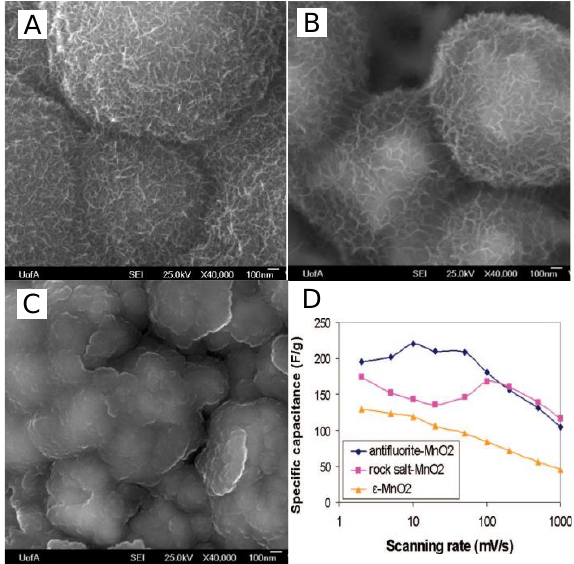
Figure 3. Morphology and crystal structure of manganese oxide prepared from 0.3 M MnSO 4 solution: SE image of ( A ) without any complexing agents, ( B ) with 0.2 M EDTA, ( C ) with 0.3 M sodium citrate, and ( D ) Specific capacitance of MnO 2 nanocrystals derived from the cyclic voltammograms (second cycle) at various cycling rates. Reproduced with permission from reference [30]. Copyright ©2008, American Chemical